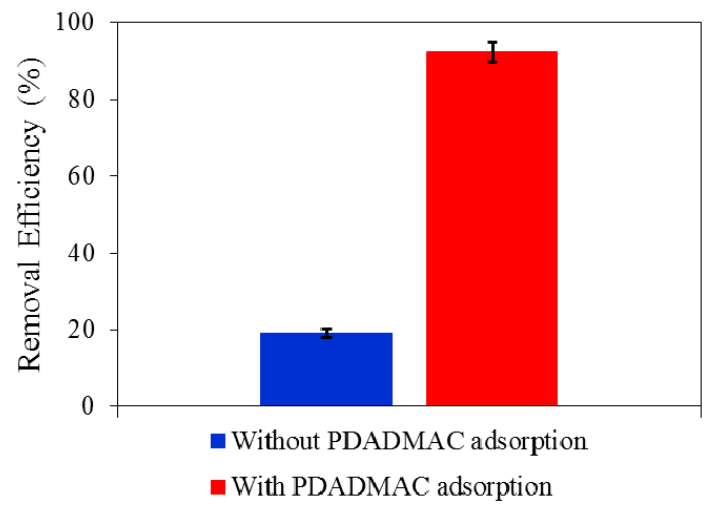
Figure 15 . Removal of AMX using silica without and with PDADMAC modification. Error bars show standard deviations of three replicates.